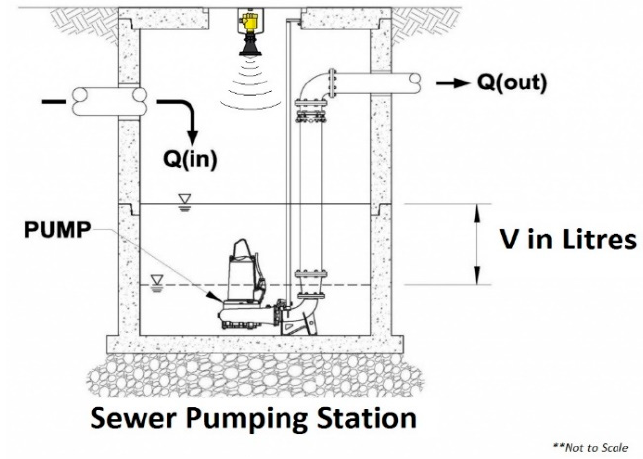
Figure 9. SPUDD on-site setup.